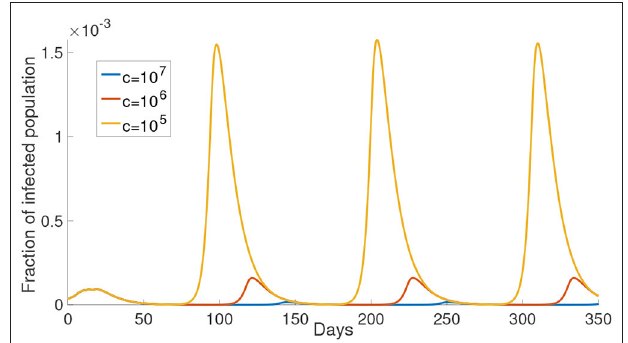
FIGURE 3 | The effect of varying the cost after infection. The cost after infection is the scalar c in Equations (12) and (13). The infected population with different cost after infection is shown in different color. The corresponding c is shown in the